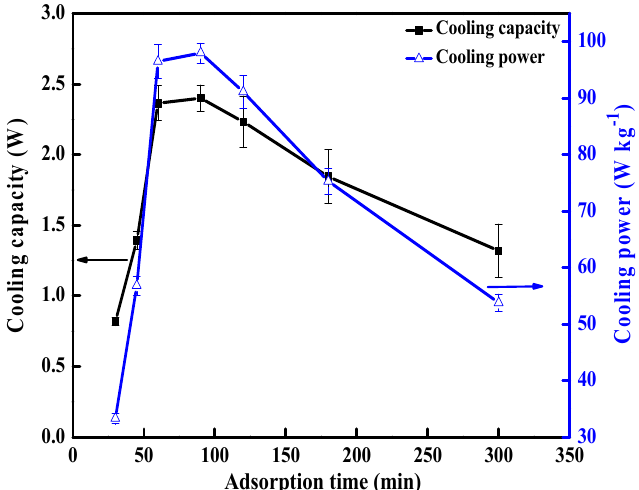
Figure 9. Cooling capacity and cooling power of an MIL-101/20%FLG-water working pair at different adsorption times.